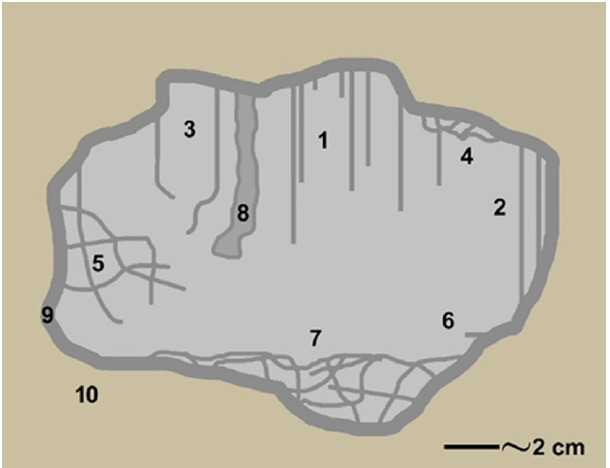
Figure 5. Schematic sketch of a cavity showing different morphological varieties of SFF: (1) Gravity-controlled linear SFF (pseudo-stalactite). (2) Coalescence of type 1 SFF with the cavity walls. (3) Gravity-controlled SFF growth continuing unoriented. (4) SFF randomly intergrown with the cavity margin. (5) Formation of stable frames of randomly oriented and curved SFF. (6) SFF with horizontal orientation and maximum length of 3 cm. (7) Cavity bottom with masses of irregular SFF embedded in chalcedony. (8) SFF consisting of intergrown filaments forming planar matted fabrics. (9) Wall lining consisting of clay minerals and chalcedony layer. (10) Dense unaltered host rock of the lava core zone. Note that individual SFF showing upward growth (“pseudo-stalagmites”) were not detected.